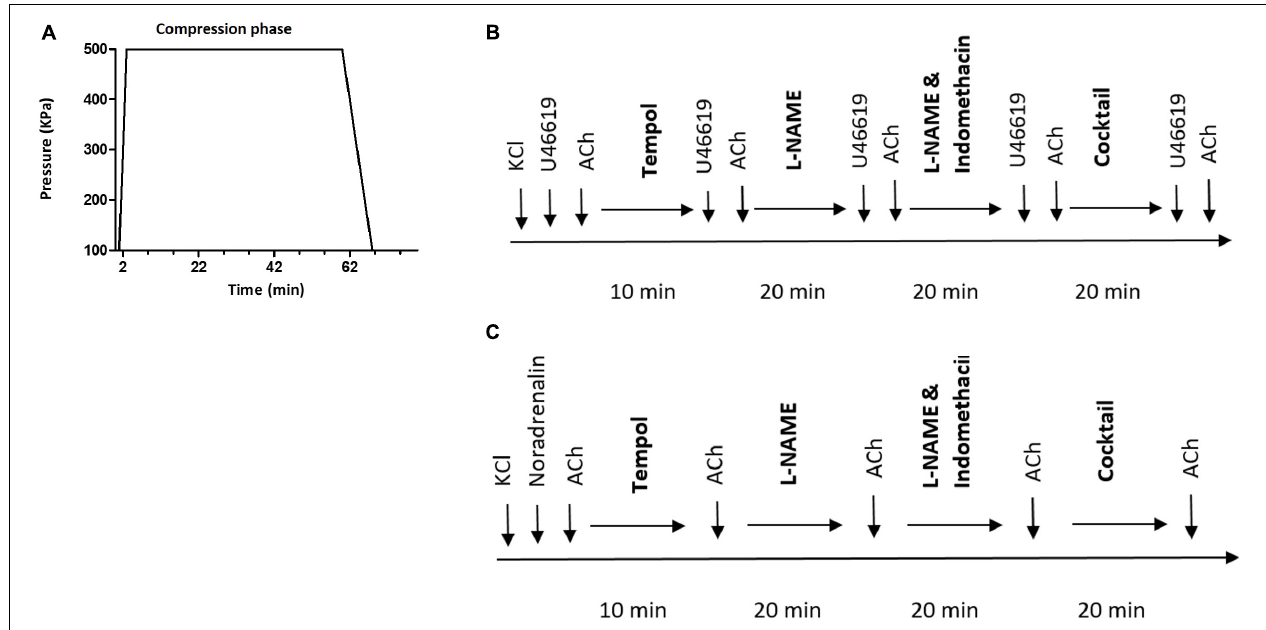
FIGURE 1 | (A) Diving protocol. Each diving rat was exposed to hyperbaric heliox gas mixture (80% He and 20% O 2 ) with compression rate of 200 kPa/min until it reached an absolute pressure of 600 kPa. The rat was exposed to hyperbaric conditions for 60 min followed by decompression at 50 kP/min; (B) schematic presentation of the protocol for myograph experiments on pulmonary and (C) mesenteric arteries. Cocktail, a mixture of L-NAME, indomethacin, Tram-34 and apamin; ACh,